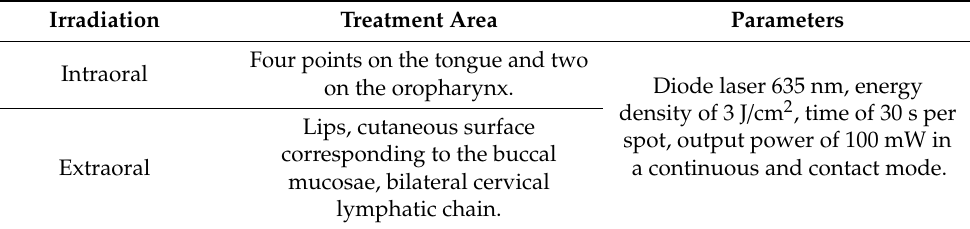
Figure 1. Photobiomodulation (PBM) treatment area for the management of oral mucositis [19]. Table 3. Photobiomodulation therapy for the management of oral mucositis parameters: Applications and treatment protocol.